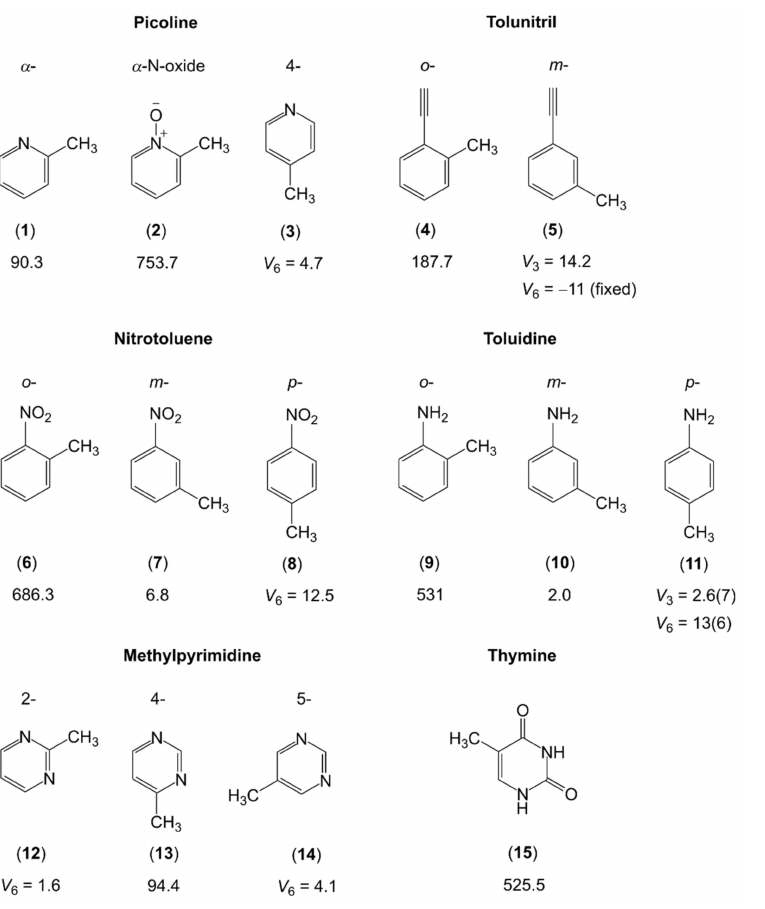
Figure 8. Barriers to methyl internal rotation in nitrogen-containing aromatic six-membered ring (in cm − 1 ). ( 1 ) α -picoline [173,174], ( 2 ) α -picoline-N-oxide [175], ( 3 ) 4-picoline [176], ( 4 ) o-tolunitril